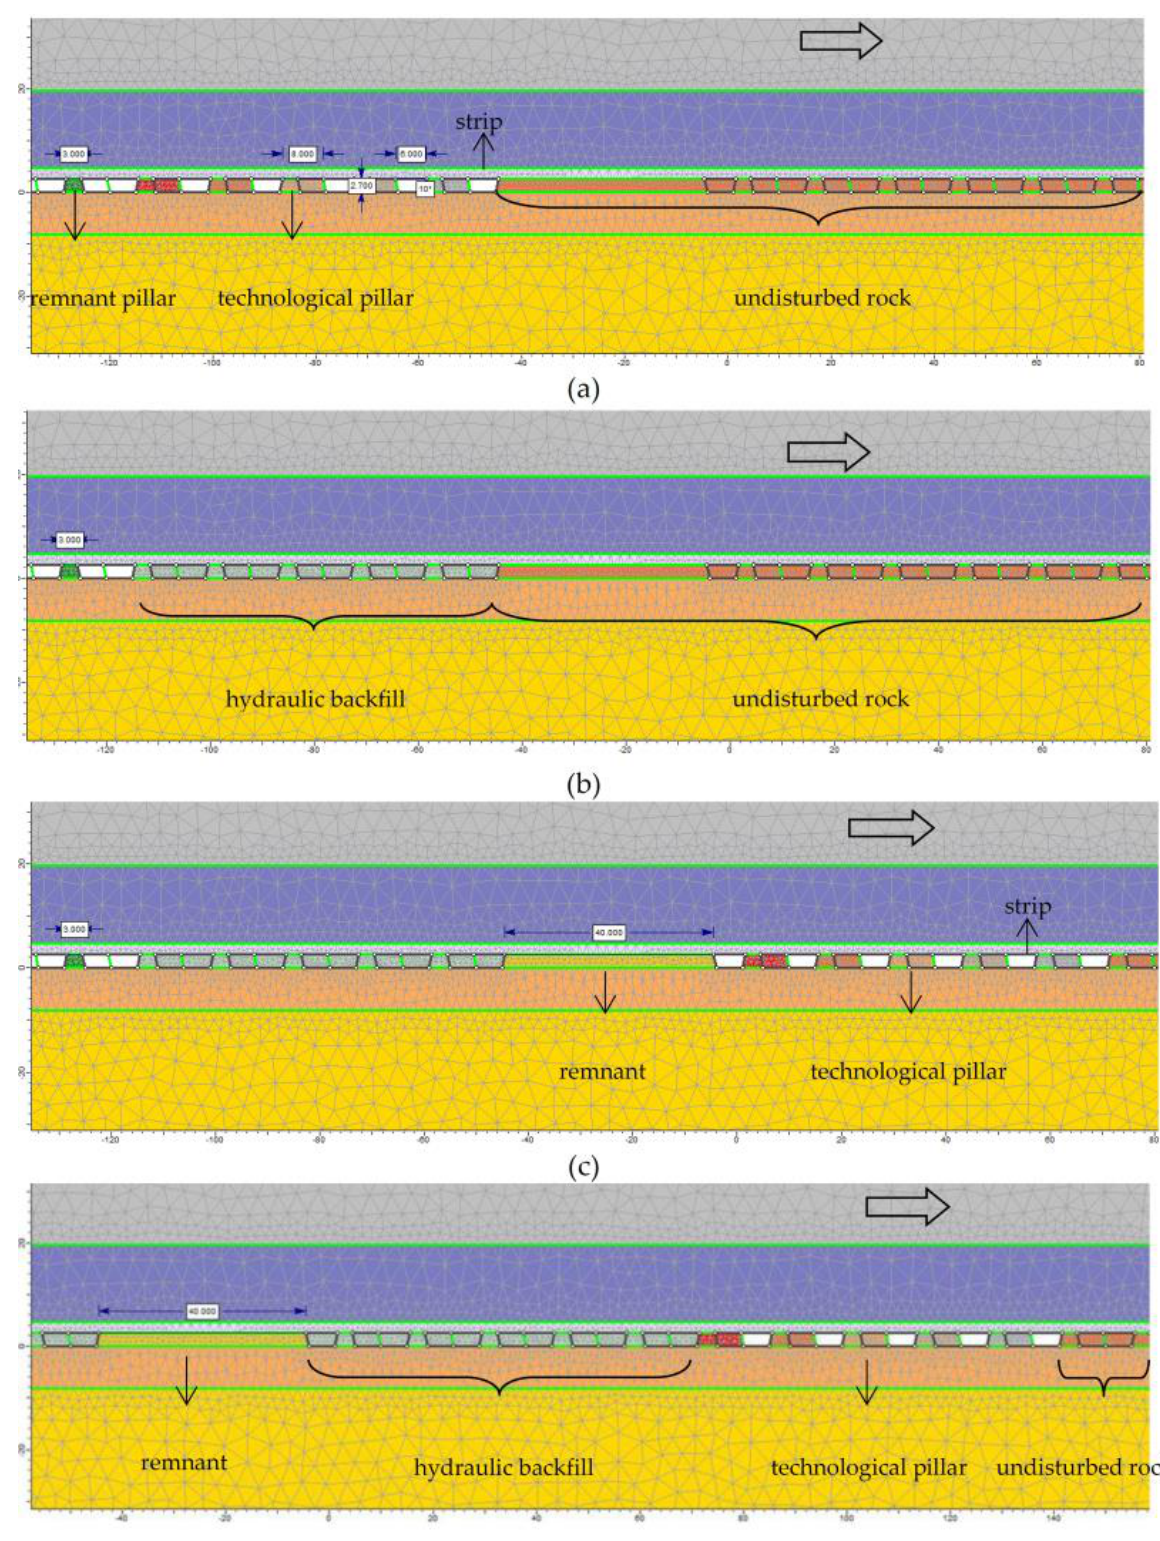
Commented [DD3]: Hyphen should be minus, please revise. Commented [KA4R3]: I confirm